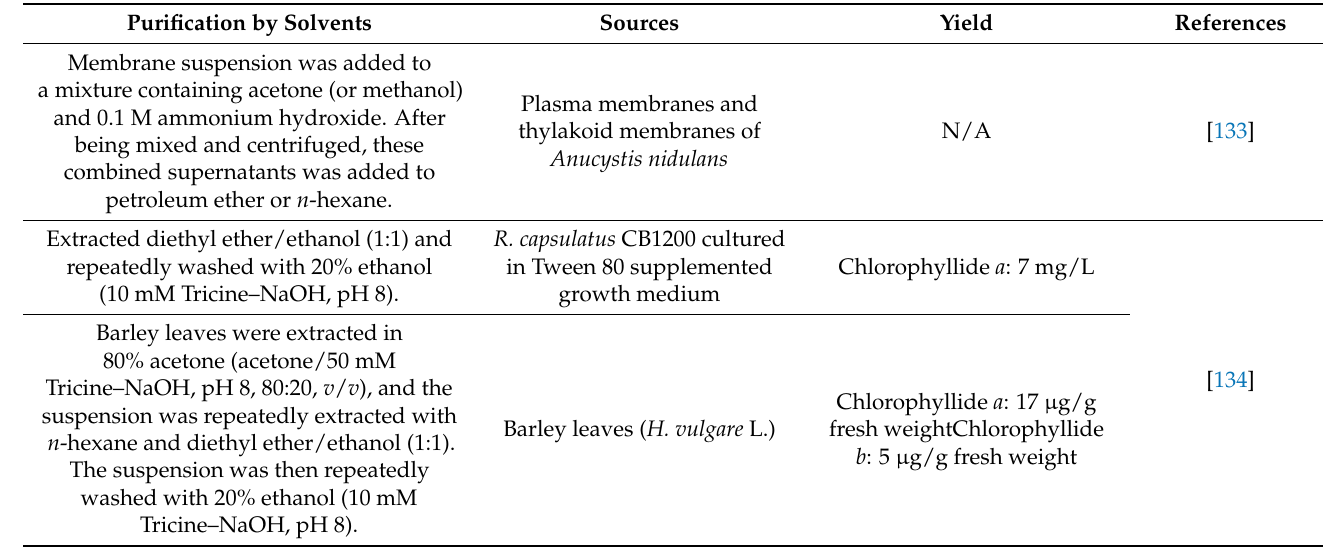
Table 3. Some examples of chlorophyllides purification by